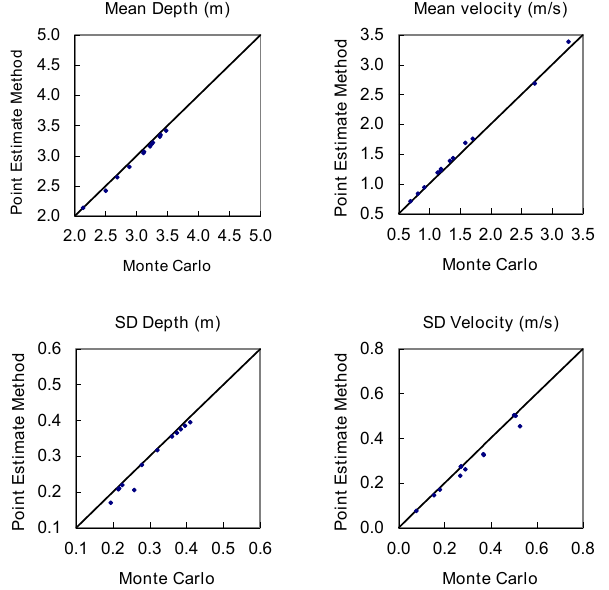
Fig. 10. 1-D HEC-RAS model. Mean and standard deviations of water depth and velocity predicted by point-estimate method against Monte Carlo. Results for n i uniformly distributed and flow case 500m 3 s − 1 . Each dot corresponds to a different RS of the model.